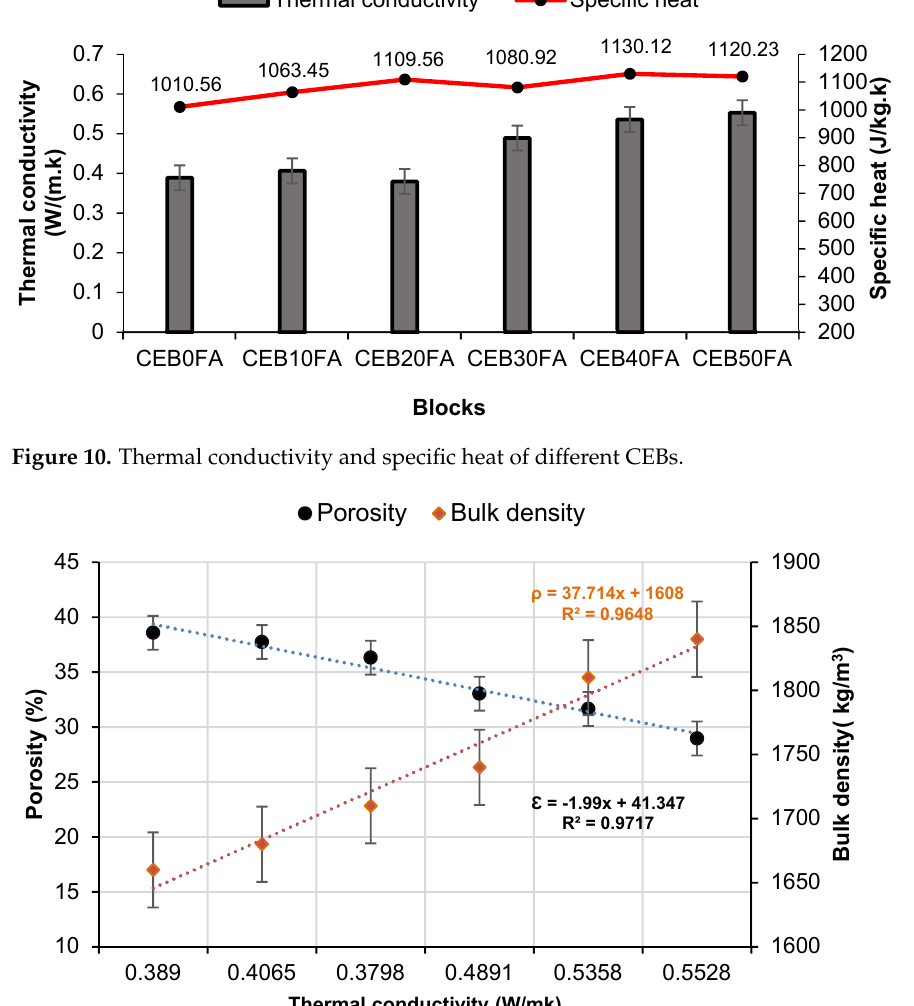
Figure 11. Relationship between thermal conductivity, porosity, and bulk density of CEBs.